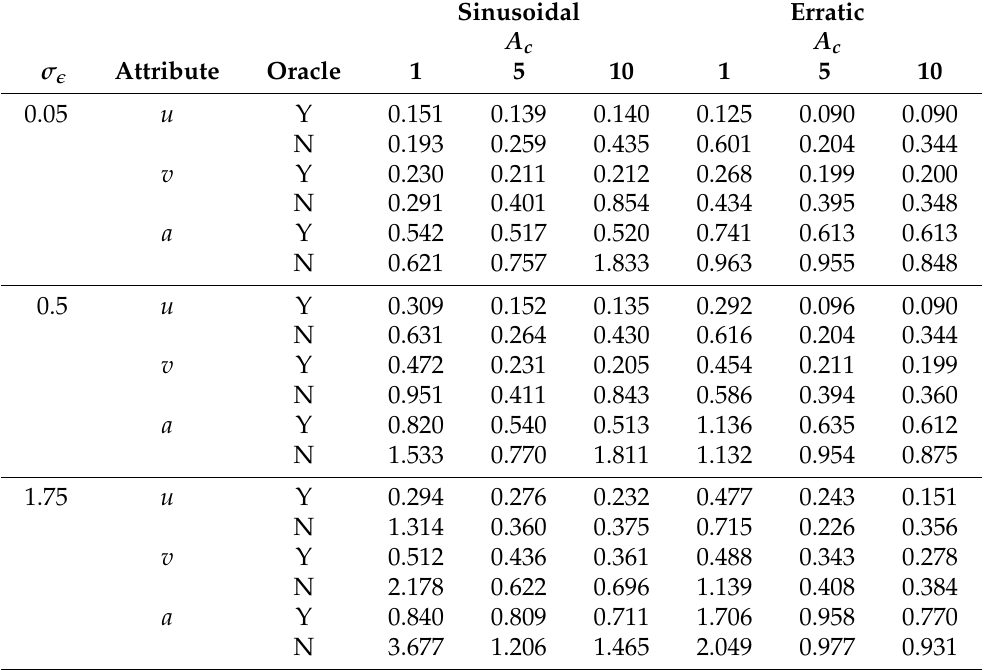
Table 3. Average posterior predictive interval widths of u , v and a for both Oracle and non-Oracle models. The models were trained on a sinusoidal training system with amplitudes A c = 1,3,5, force error σ 2 (cid:101) = 0.05,0.5,1.75 and validated on both Erratic and Sinusoidal systems with Erratic system with typical validation amplitude of 5, created using Erratic system variances ψ 2 Sinusoidal parameters A p = 5, σ (cid:101) = 0.5 . Based on 100